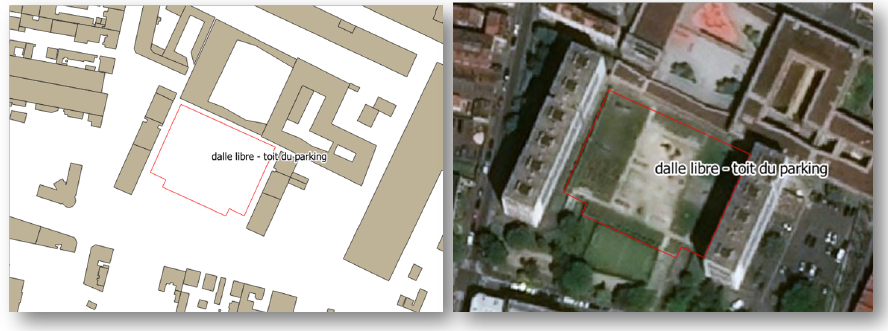
Figure 12. A contribution that is complex to classify as vandalism or as an